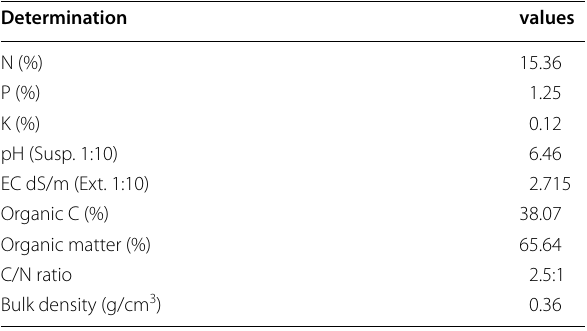
Table 2 Chemical composition of isolated soy protein samples used in the study on dry weight